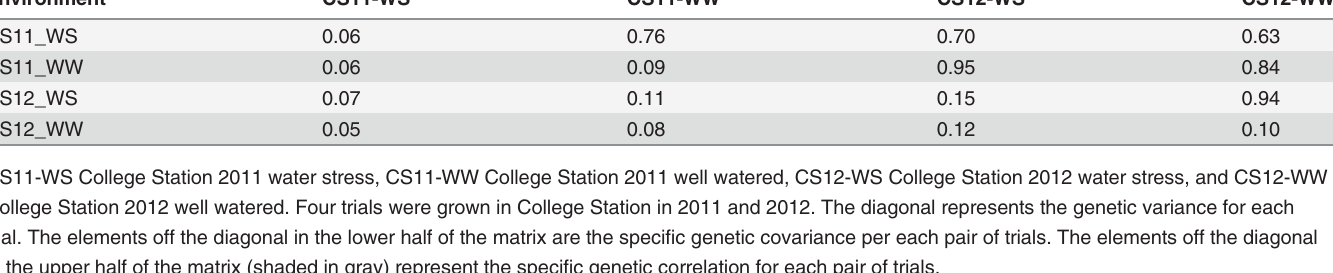
Table 5. Variance-covariance unstructured matrix for a fl atoxin level (ng g − 1 ) for the College Station 2011 and 2012 trials and Mississippi 2012 trial.